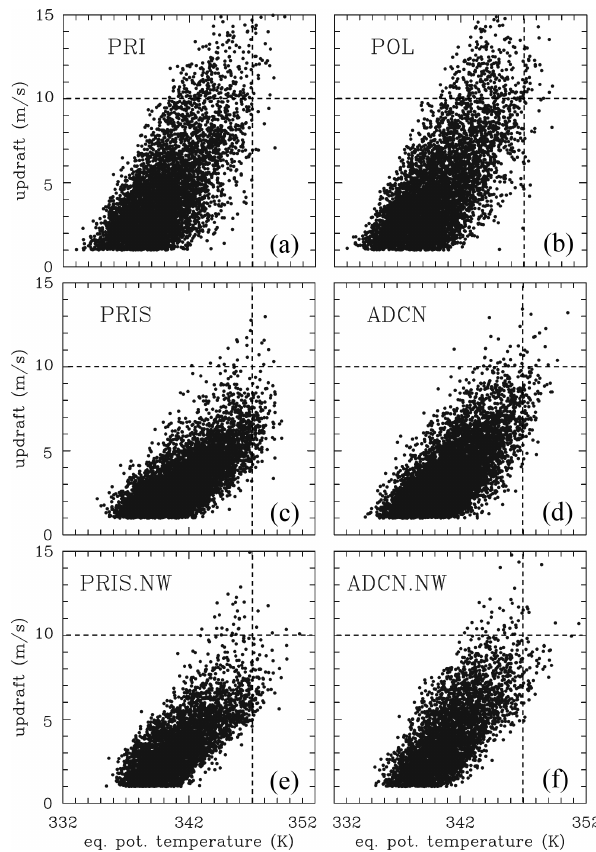
Figure 5. Updraft versus (cid:50) e for four IAB simulations (PRI and POL; a and b ), three 2MOM simulations (randomly selected from seven members for PRIS and ADCN ensembles; c and d ), and three 2MOM simulations (from PRIS.NW and ADCN.NW ensem- bles; e and f ). Data at 4km height for hours 6 and 7 in grid vol- umes with updraft larger than 1ms − 1 and total condensate larger than 1gkg − 1 . Dashed horizontal and vertical lines show values of 10ms − 1 and 347K to better expose differences discussed in the text.